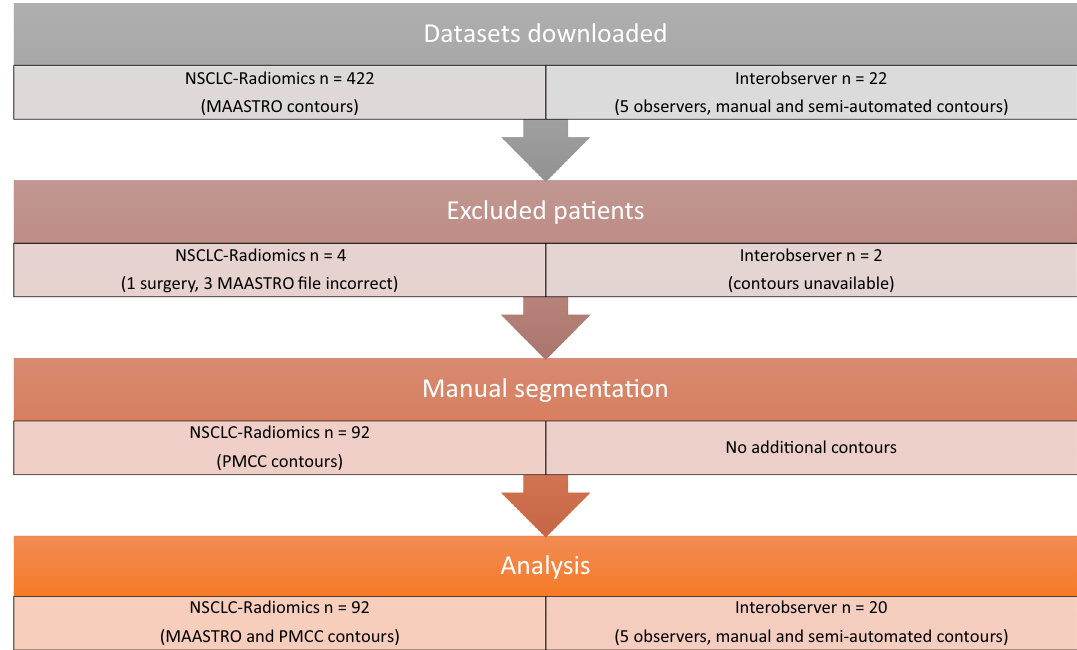
Figure 1. Methods flow chart. This flow chart describes the process of patient selection, creation of contours, and exclusion for the two datasets downloaded from the open access online archive ‘The Cancer